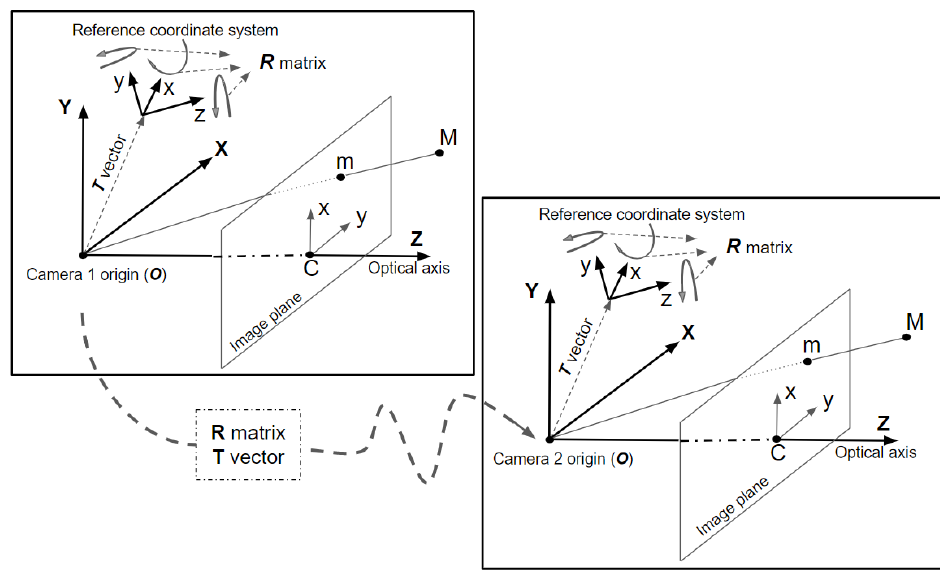
Figure 4. Camera coordinate system composed of the camera systems of both cameras: camera 1 ( left ) and camera 2 ( right ). The relation between both coordinate systems is given by a rotation matrix ( 𝑅 ) and a translation vector ( 𝑇 ).